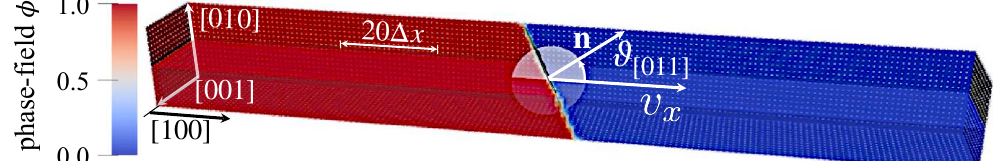
Figure 2. The stationary interface motion simulation with interface orientations, which differ from the principal axes of the computational